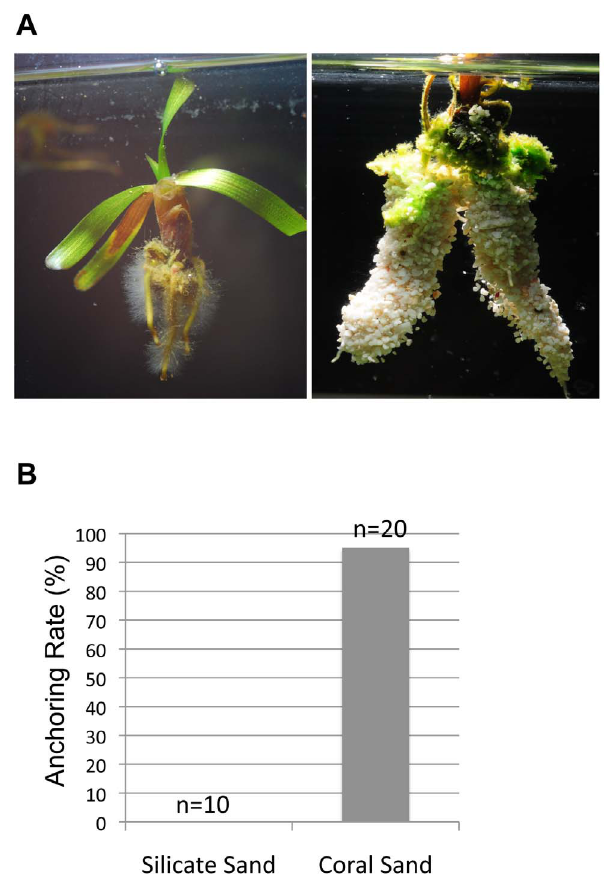
Figure 4. Thalassiahemprichii seedlings anchor to a bed of coral sand but not silicate sand. Seeds were allowed to germinate on beds of silicate or coral sand in the same aquarium. Seedlings anchored themselves using root and root hairs to grip coral sand (A, right and B) but not silicate sand (A, left and B; Chi -square test, p , 0.01). Seedlings not anchored were floating in the water column when the vegetative tissues became dominant (A, left).